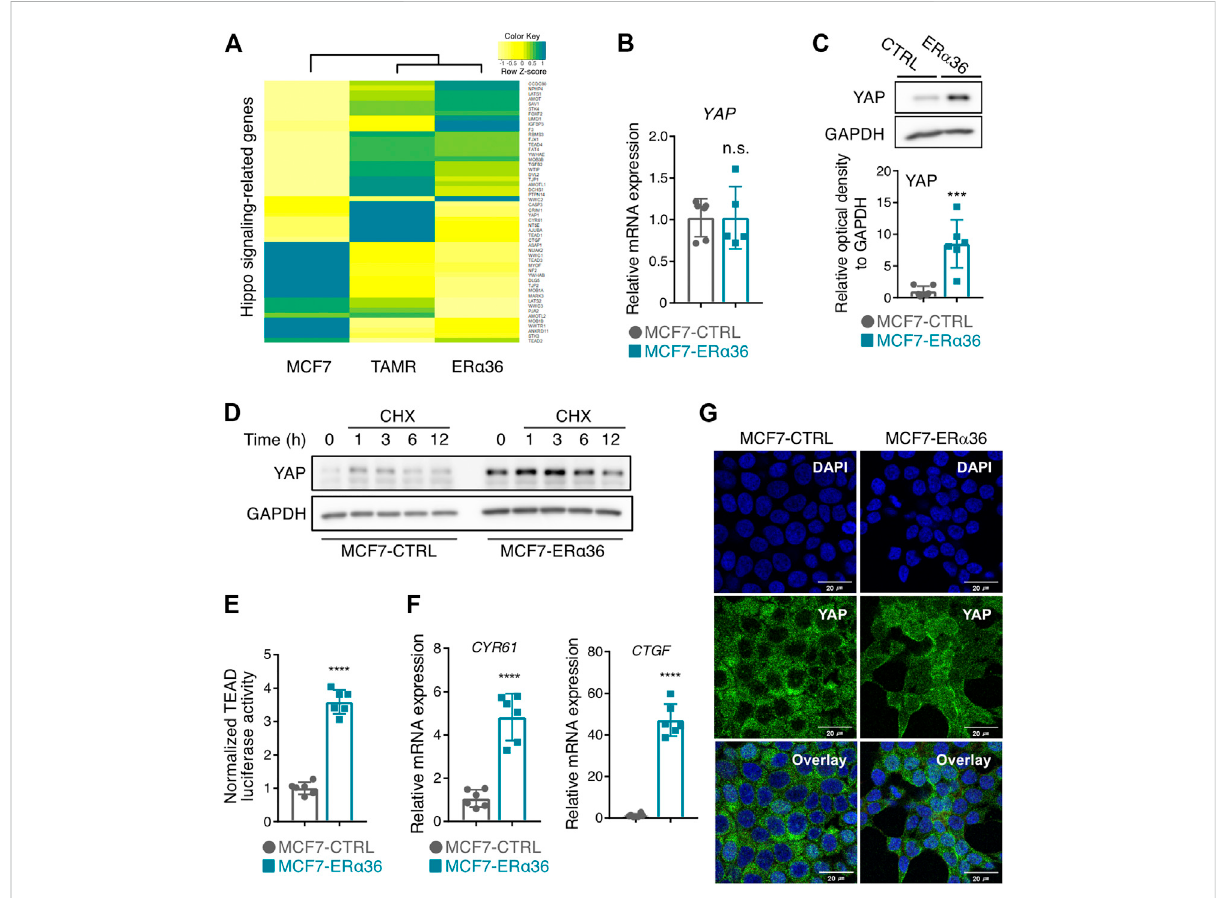
FIGURE 2 Activation of YAP by overexpression of ER α 36 in MCF-7 cells. (A) Hippo signaling-related gene expression derived from RNA-sequencing analysisofMCF-7,TAMR-MCF-7, andMCF-7-ER α 36cells. (B) ThemRNAlevelsof YAP inMCF-7-CTRLandMCF-7-ER α 36cells. (C) TheelevatedYAP proteinexpressioninMCF-7-ER α 36cellscomparedtoMCF-7controlcells(up)andtherelativeopticaldensityofYAP(down). (D) Thehalf-lifeofYAP protein was analyzed in a time-dependent condition in the presence of cycloheximide (100 μ M). (E) YAP/TAZ-responsive TEAD reporter activities in the indicated cells. (F) The mRNA levels of CTGF and CYR61 in the indicated cells. (G) The elevated nuclear expression of YAP in the indicated cells analyzed by immunocytochemical staining. All statistical signi fi cance of the differences was determined by unpaired two-tailed Student t test. n. s., not signi fi cant; *, p < 0.05; ****, p < 0.001 signi fi cant as compared with MCF7-CTRL cells. CTRL, control vector. CHX,